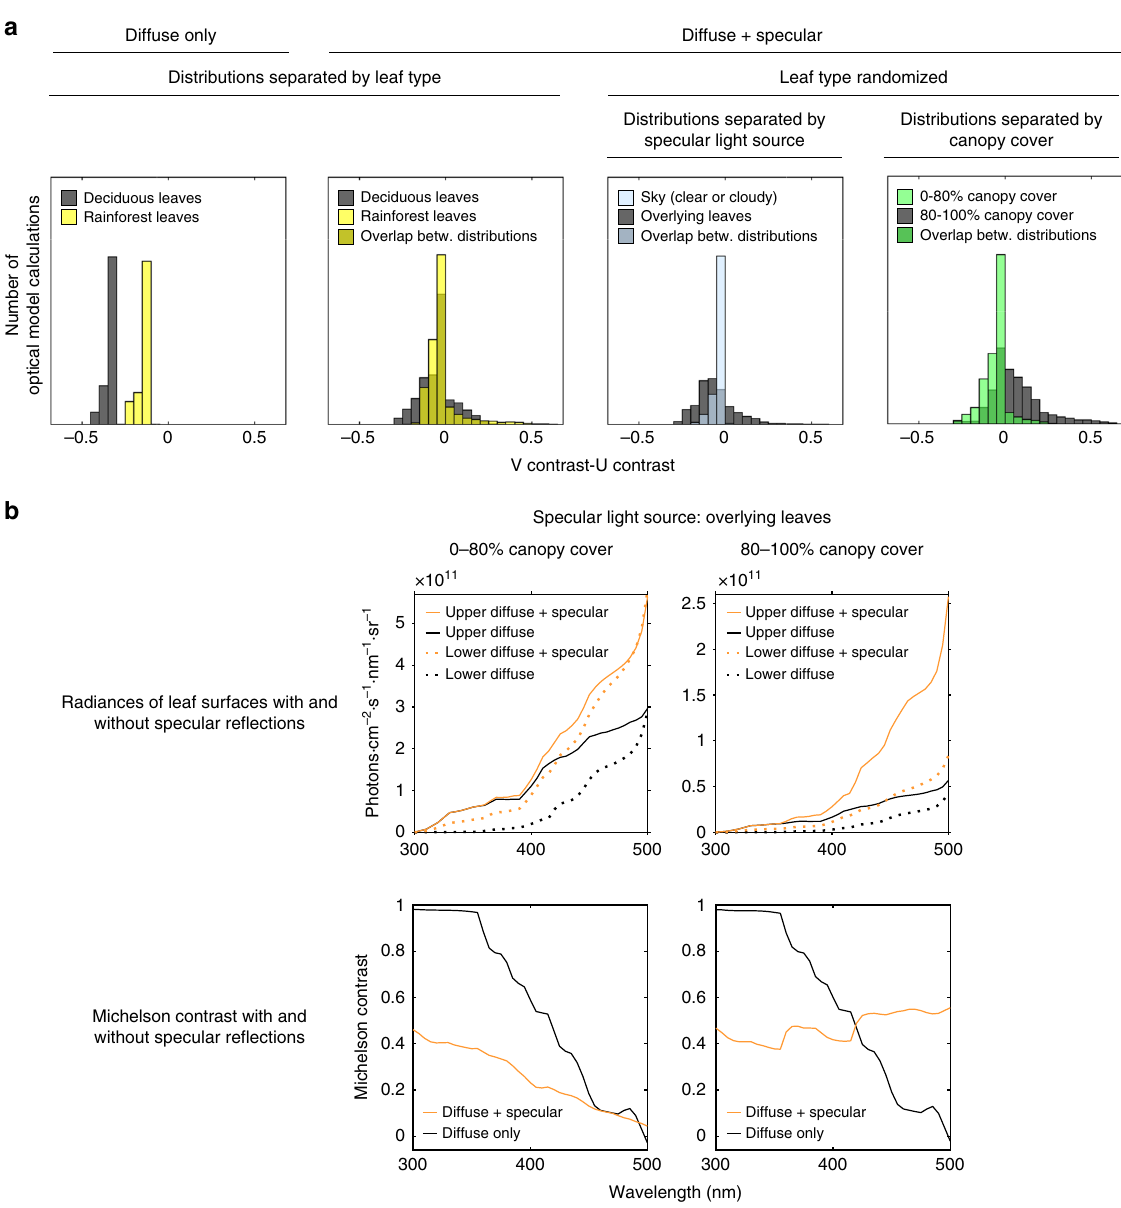
Fig. 7 Optical model validates the effect of habitat observed in multispectral data and reveals the mechanism behind it. a First panel: when only diffuse re fl ectance and transmittance were modeled, the U-cone always saw higher leaf-contrast, regardless of whether deciduous or rainforest leaf spectra were used. Second panel: when specular re fl ections were added to the model, the V-cone sometimes saw higher leaf-contrast, but there was no clear separation between deciduous and rainforest leaf types. Third panel: by plotting leaves illuminated by different specular light sources, we found that the V-cone saw higher leaf-contrast only when overlying leaves were the specular light source. Fourth panel: comparing habitats with different amounts of overlying canopy demonstrated a clear separation between open and closed habitats, with the V-cone seeing higher leaf-contrast in closed habitats ( >80% canopy cover), and the U-cone seeing higher leaf-contrast in open habitats ( <80% canopy cover). We infer that the differences seen between habitats were due to differences in habitat openness, and not leaf optical properties. b Median radiance spectra of leaf surfaces modeled with and without specular re fl ections when the specular light source was overlying leaves. Leaf type (deciduous or rainforest) was randomized. Here, we can see that specular re fl ections from the upper leaf surface shift the spectral shape of upper leaf surface re fl ectance more than lower leaf surface re fl ectance, and that this difference is more pronounced in closed habitats. The result of this in terms of median achromatic contrast across the UV-blue spectrum can be seen in the lower two panels. In closed habitats (lower right panel), specular re fl ections shift upper leaf surface radiance such that contrast becomes higher at longer wavelengths. Note that all habitat and environmental parameters that go unmentioned in the fi gure were randomized in each of 10,000 repetitions of the